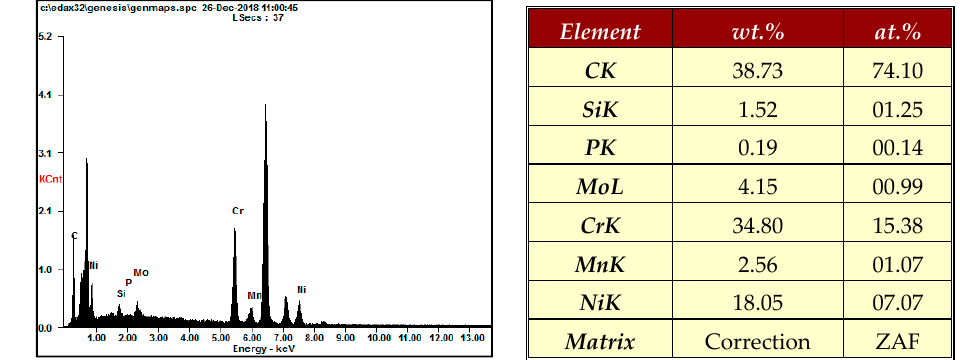
Figure 13. Chemical elements of 316L SUS wire after finishing with ecological magnetic abrasive tools (Ra: 0.06 µm, 1200 rpm, 10 Hz).